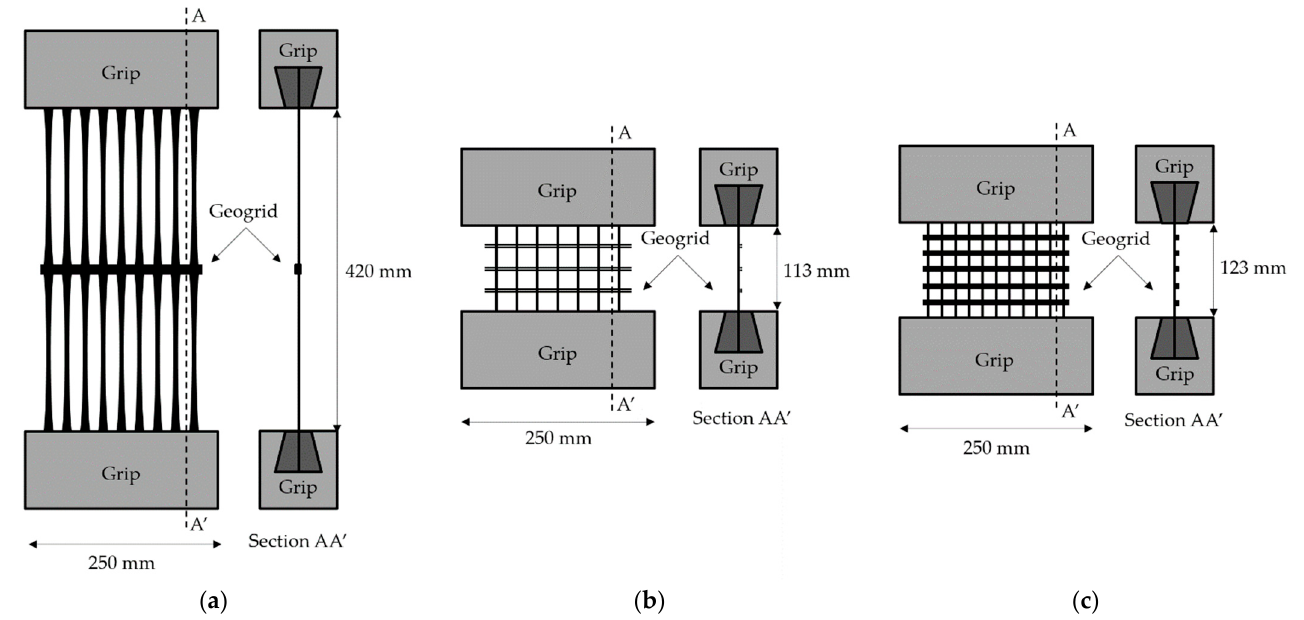
Figure 5. Setup of the tensile tests carried out on geogrids: ( a ) EG; ( b ) WG-I; and ( c ) WG-II.